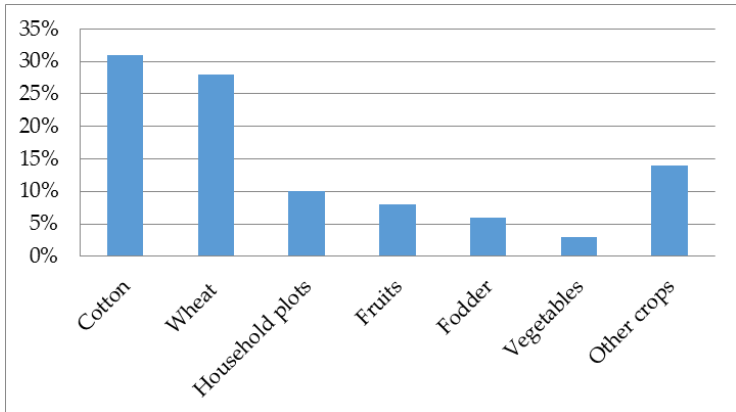
Figure 2. Crop allocation plans for Kashkadarya Province in 2016.